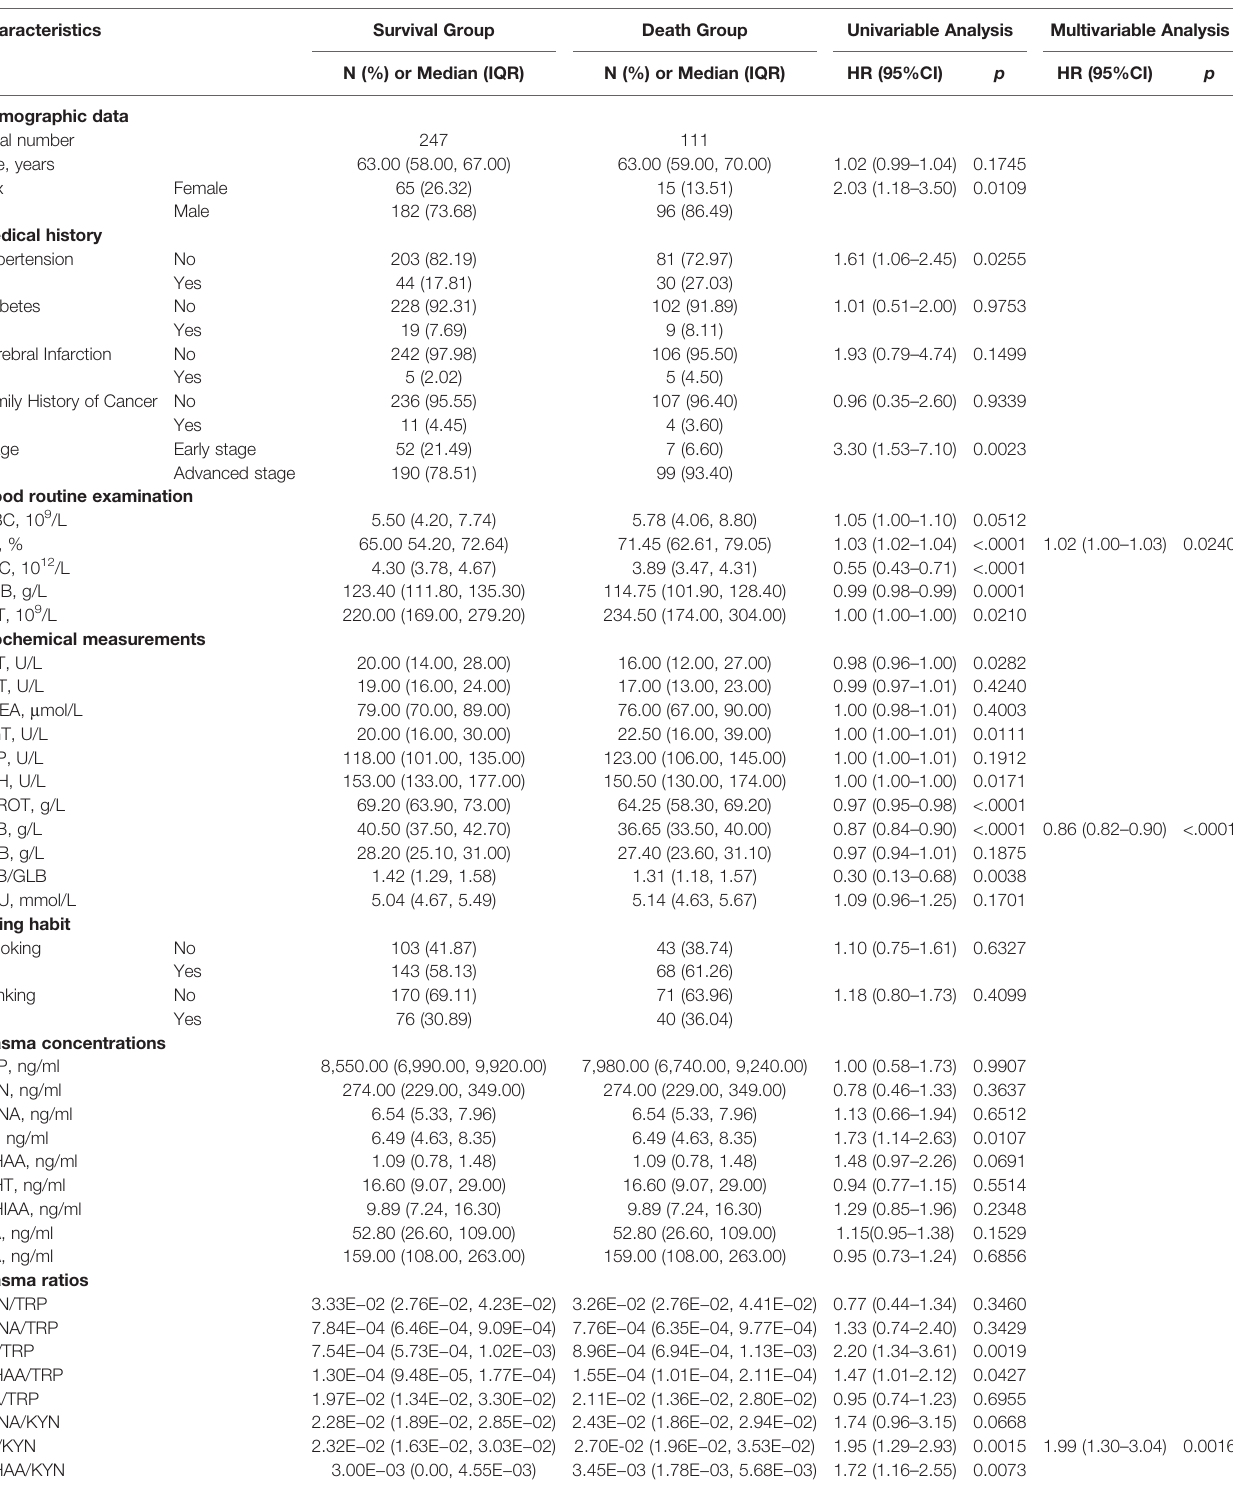
TABLE 4 | Associations of metabolites and baseline data with overall survival of